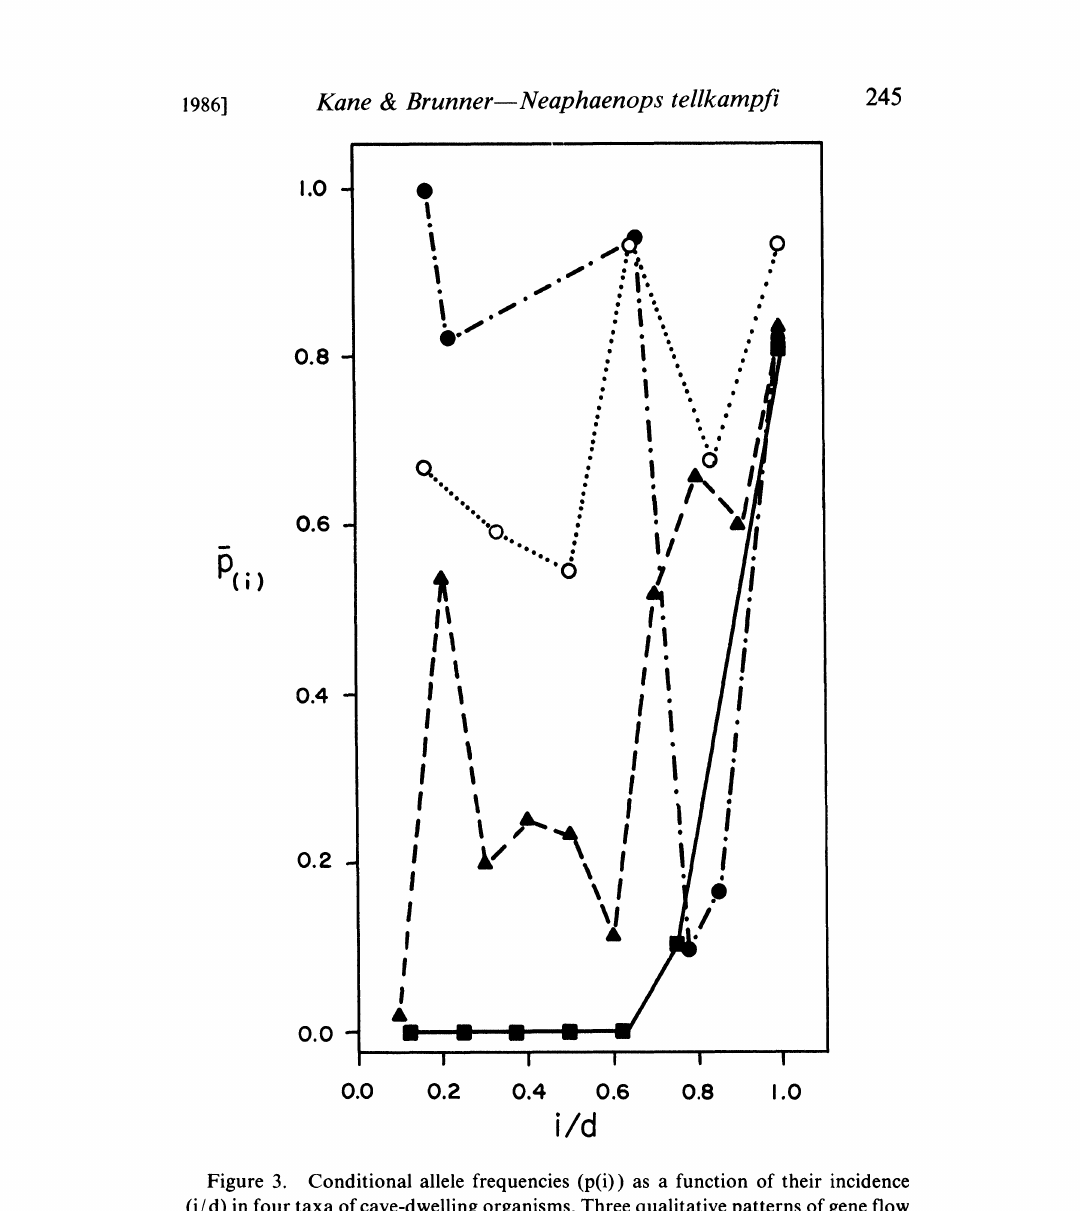
Figure 3. Conditional allele frequencies (p(i)) as a function of their incidence (i/d) in four taxa of cave-dwelling organisms. Three qualitative patterns of gene flow are inferred: low gene flow: Neaphaenops tellkampfi (filled circles) and Ptomaphagus hirtus [open circles (data from Laing et al., 1976) ]; intermediate gene flow: Hadenoe- cus subterraneus [triangles (data from Caccone, 1985)]; and, high gene flow: Nea- phaenops tellkampfi tellkampfi